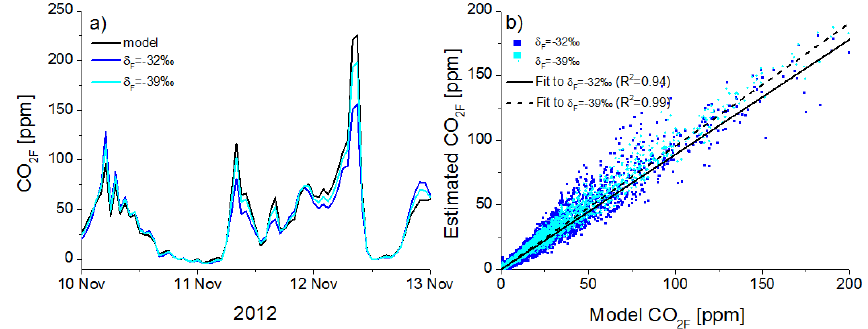
Figure B1. (a) Example period showing fuel CO 2 of different fuel CO 2 estimation methods and reference modeled fuel CO 2 . Dark blue: mean δ F is − 32‰; cyan: mean δ F is − 39‰. (b) Correlation plot between estimated and modeled fuel CO 2 for mean δ F = − 32‰ (dark blue and solid line) and mean δ F = − 39‰ (cyan and dotted line) during the entire year of 2012. Fuel CO 2 can be estimated much better using δ 13 C(CO 2 ) when the fuel δ 13 C signature is strongly depleted with respect to the biosphere. Note that the slope slightly changes when using more depleted sources. This is because few high fuel CO 2 peaks span the linear regression and therefore determine the slope to a large degree, but as a general tendency for the Heidelberg data set, the high fuel CO 2 peaks exhibit an isotopic signature, which is more enriched as the isotopic signature of the mean fuel source